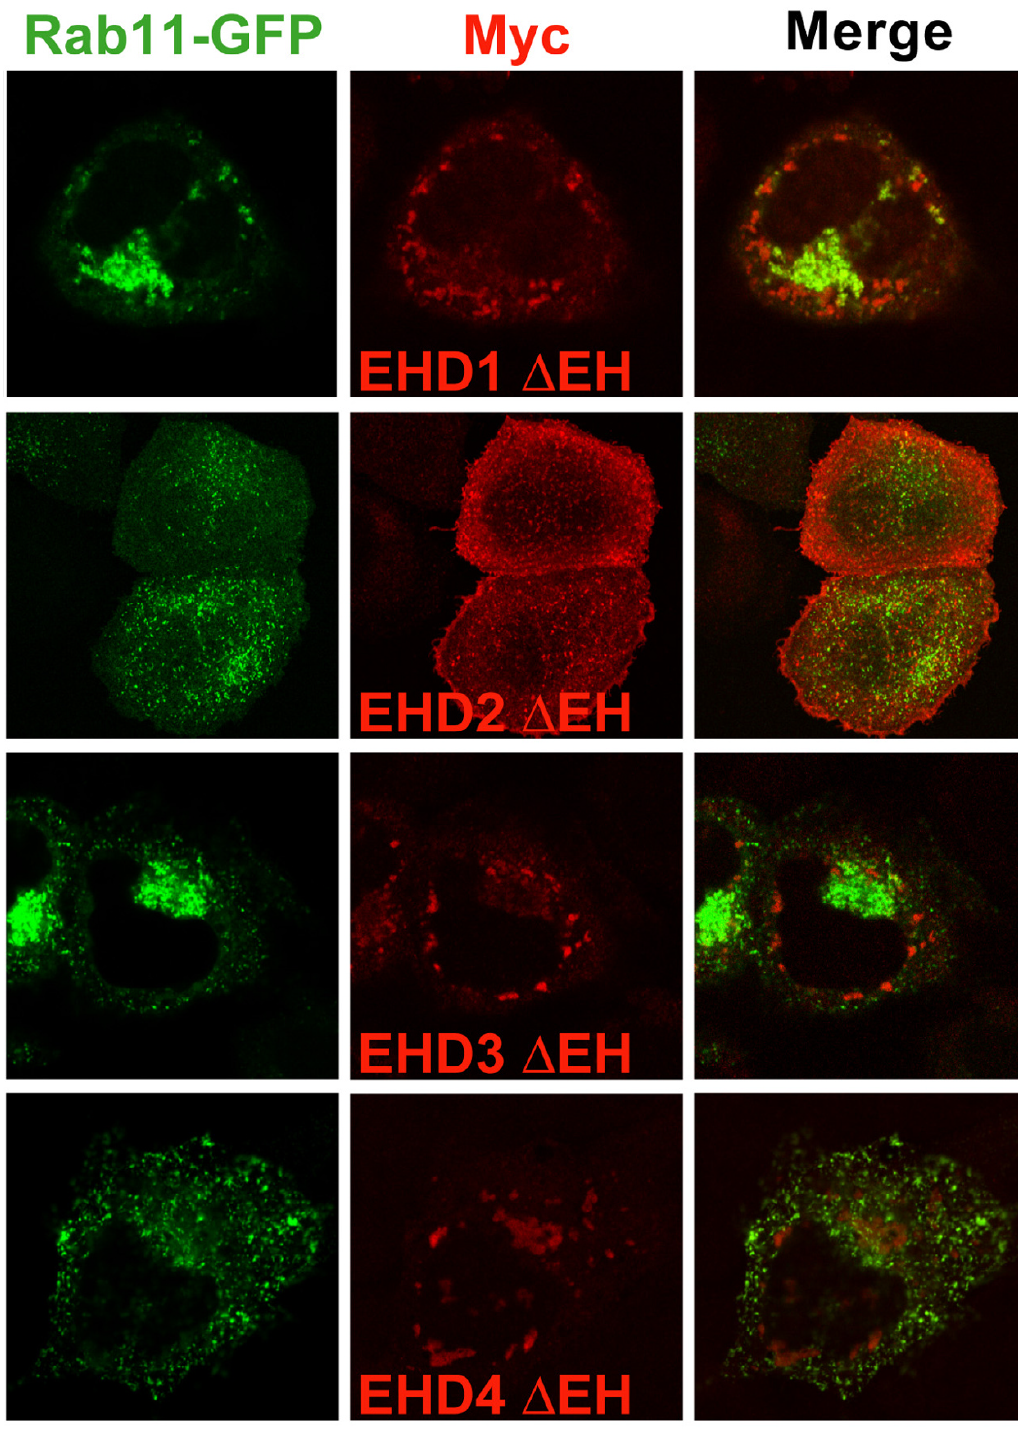
Figure 8 Myc-EHD1 ∆ EH and EHD3 ∆ EH cause perinuclear clustering of Rab11-GFP . HeLa cells were co-transfected with Myc-EHD ∆ EH proteins (red) and Rab11-GFP (green) for 24 h, fixed, stained with antibodies for Myc (9E10), mounted and scanned by a confocal microscope equipped with a 100× objective